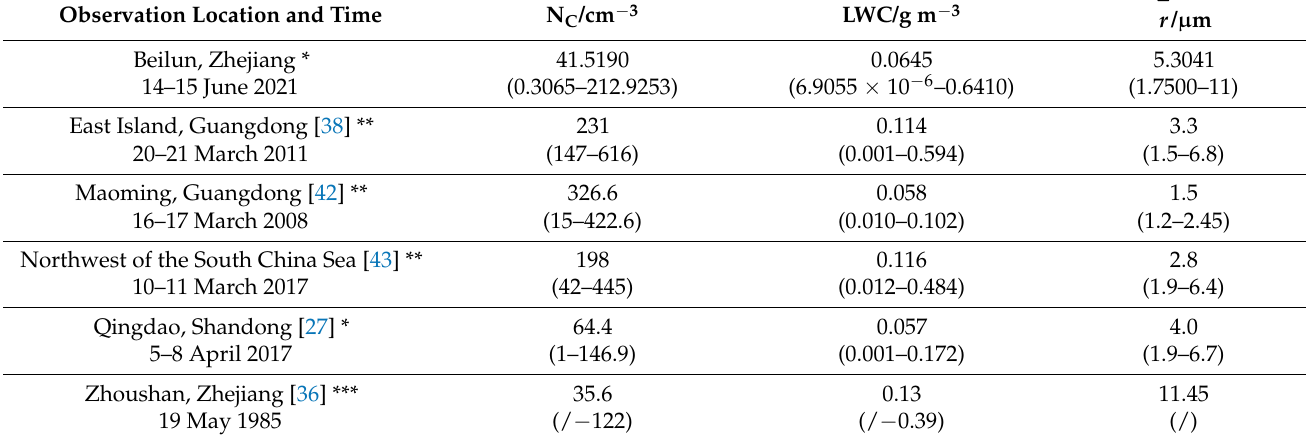
Table 5. Comparison of individual cases of sea fog microphysical characteristics between the Beilun District of Ningbo City and other coastal areas in